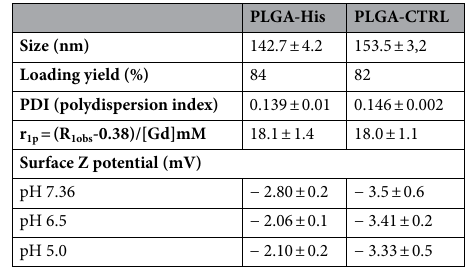
Table 1. Characterization of PLGA-His and PLGA CTRL NPs.